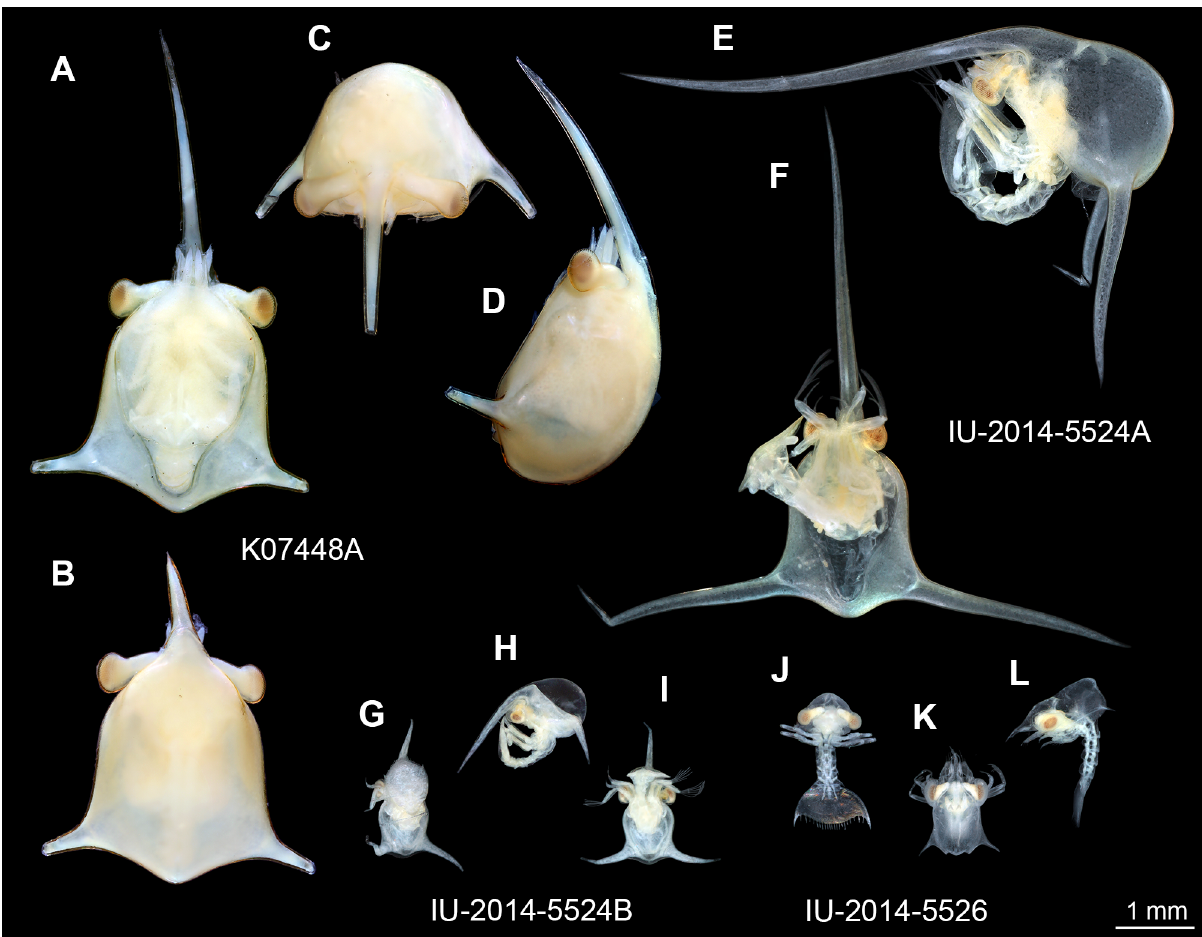
Figure 3. Larvae of the group Hippidae, museum specimens under cross-polarized light. A–D : Specimen ZMH-K07448A. A . Ventral view. B . Dorsal view. C . Anterior view. D . Lateral view. E, F : Specimen MNHN-IU-2014-5524A. E . Lateral view. F . Ventral view. G–I : Specimen MNHN-IU-2014-5524B. G . Ventral view. H . Lateral view. I . Posterior view. J–L : Specimen MNHN-IU-2014-5526. J . Anterior view. K . Dorsal view. L . Lateral